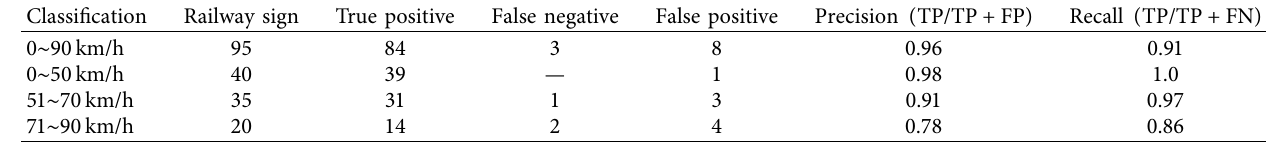
Table 2: Verification of recognizing and detecting algorithm railway signs.